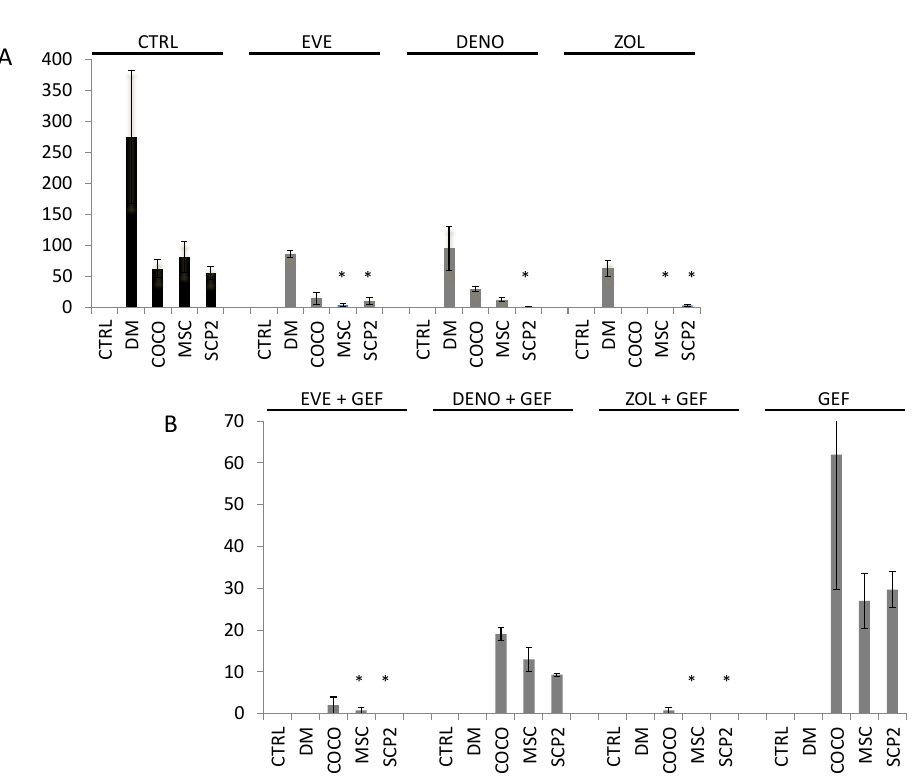
Figure 6. Eve and Zol on osteoclasts together with Gef treatment on MSC and SCP2 totally abrogated osteoclastogenesis. ( A ) Osteoclastogenesis assay from PBMC treated with bone-targeted therapy drugs (Den and Zol) and Eve. Osteoclastogenesis differentiation was evaluated in PBMC cultured with basal media with the addition of growth factors MCSF and RANKL, or with CM from MSC-SCP2 in COCO or mono-culture and treated with drugs; ( B ) Drug effects on osteoclastogenesis in combination with Gef. During the osteoclastogenic assay bone-targeted therapy drugs and Eve were added. Significance was compared to untreated osteoclasts; * p < 0.05.